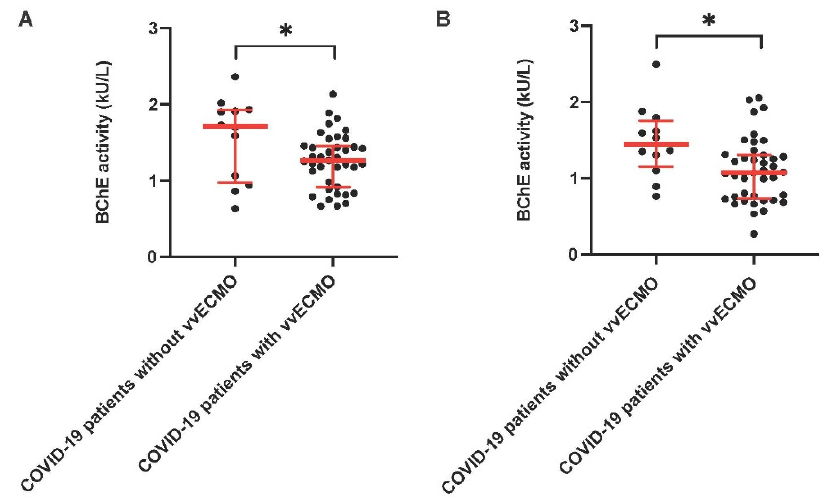
Figure 3. BChE activity in critically ill COVID-19 patients who did not require vvECMO therapy during the 28-day observation time compared to patients who required vvECMO therapy. Scatterplots represent the BChE activity in critically ill COVID-19 patients who did not require vvECMO therapy during the observation period of 28 days (n = 12) compared to patients with vvECMO on day 1 (1.713 U/L (971–1.925) vs. patients on vvECMO support (n = 39): 1.264 U/L (916–1.456)); ( A ) and on day 3 after ICU admission (1.447 U/L (1.125–1.754) vs. patients on vvECMO support (n = 40): 1.073 U/L (735–1.307)); ( B ).* p < 0.05 Mann–Whitney U-Test.